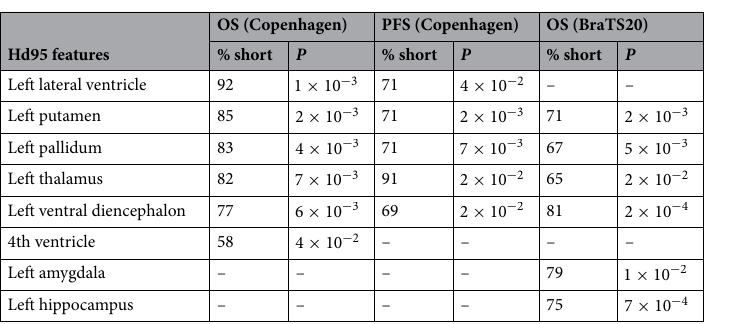
Table 3. Percentage of short survivors among the subjects in the highest 10% range of individual Hd95 feature values. The table also shows the P-value of a log-rank test between the survival times of subjects within and outside the highest 10% range. Brain structures where the log-rank P-value > 0.05 are